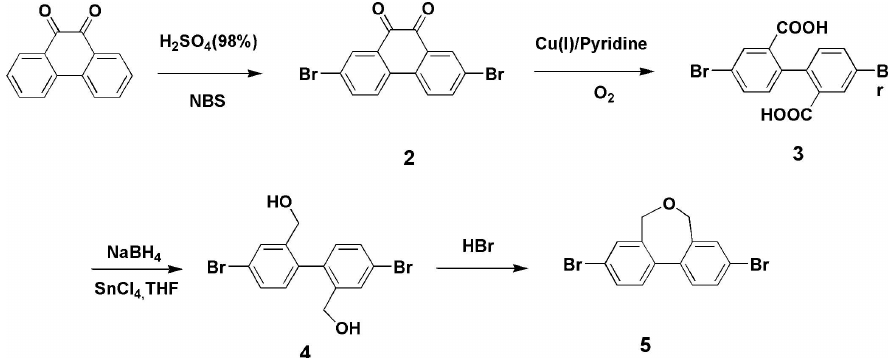
The structure of the title compound, with the atom-labelling Displacement ellipsoids are drawn at the 30% probability level of arbitrary radii.